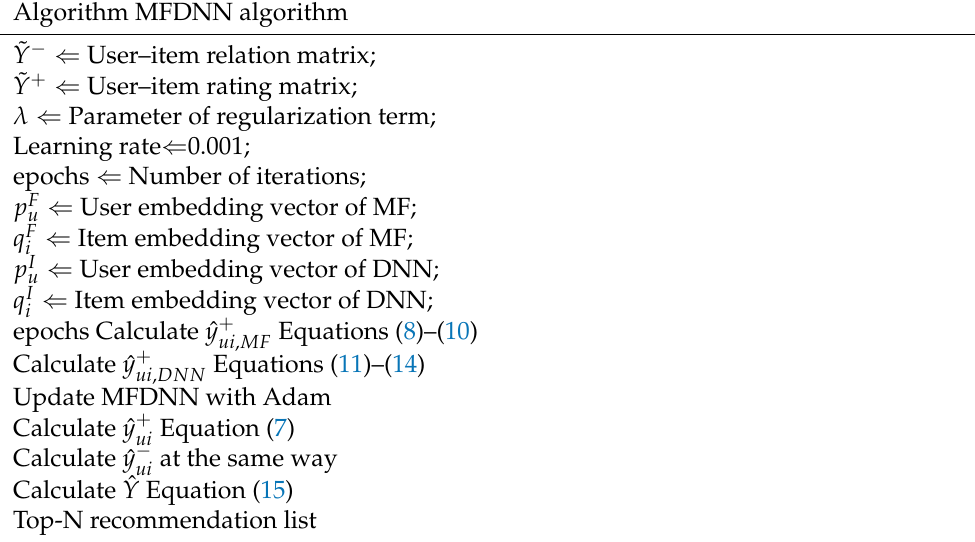
Table 2. The MFDNN algorithm.